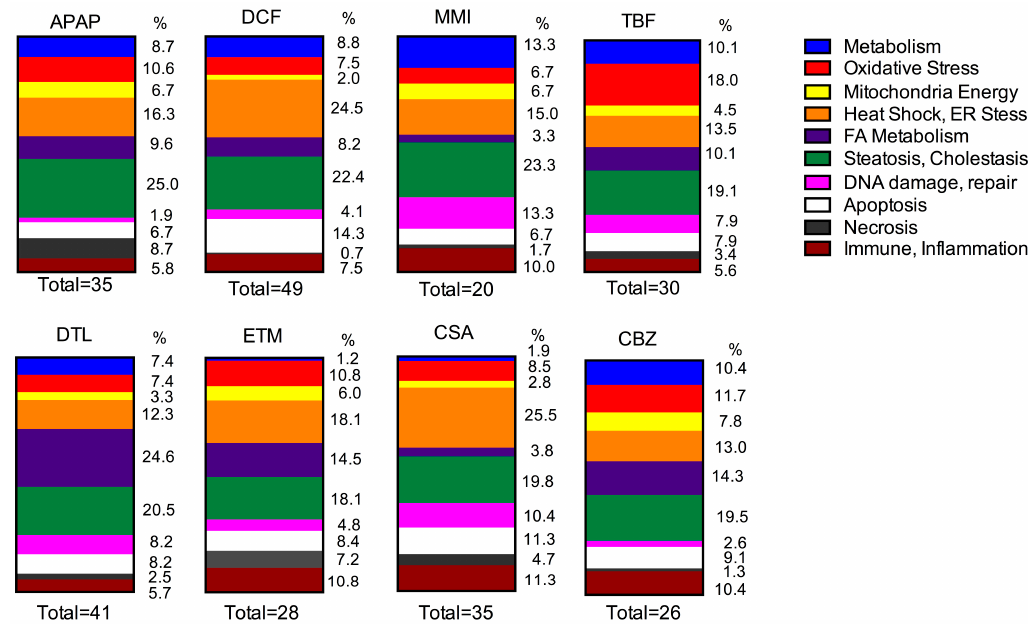
Figure 4. The gene categories for each drug are arranged to compare drug response of the 8 drugs used in this study. The percentage of genes represented by each category is based on the number of significant total gene changes for each drug, which is listed at the bottom of each bar graph.